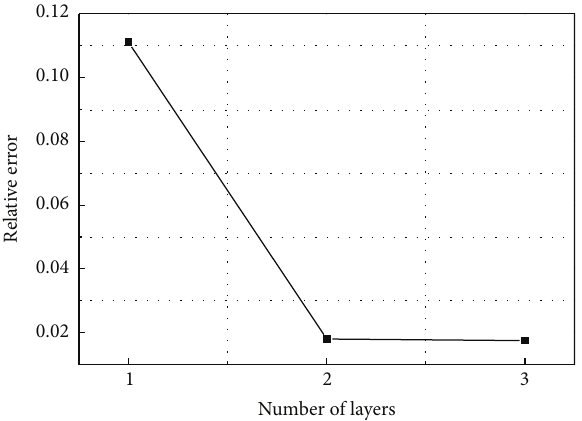
Figure 8: Relative errors with the number of layers.